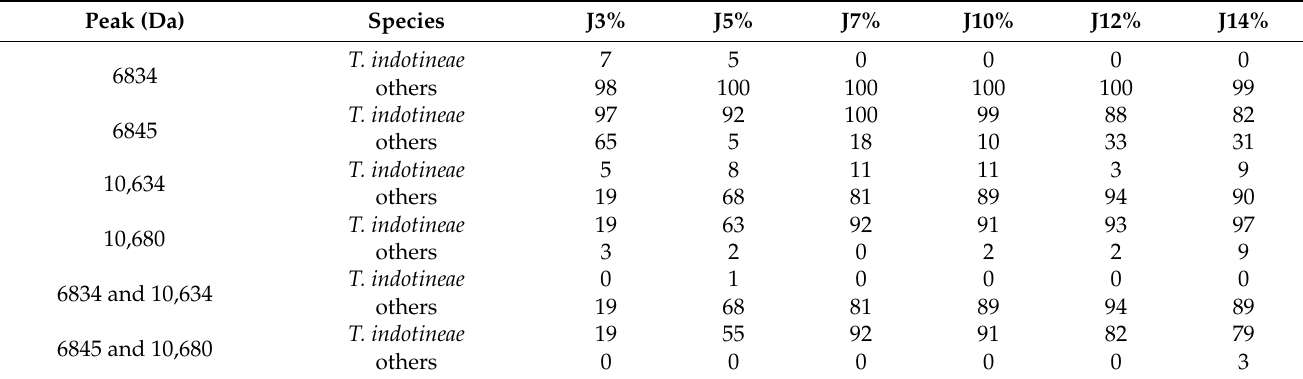
Table 3. Percentage of spectra containing the specific peak in the T. mentagrophytes/interdigitale spectra and in the T. indotineae